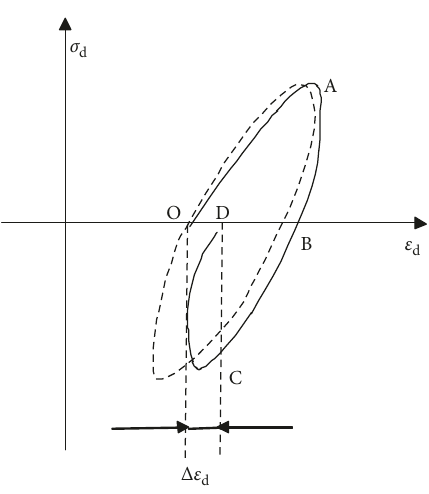
Figure 6: The hysteresis curve of LCES.